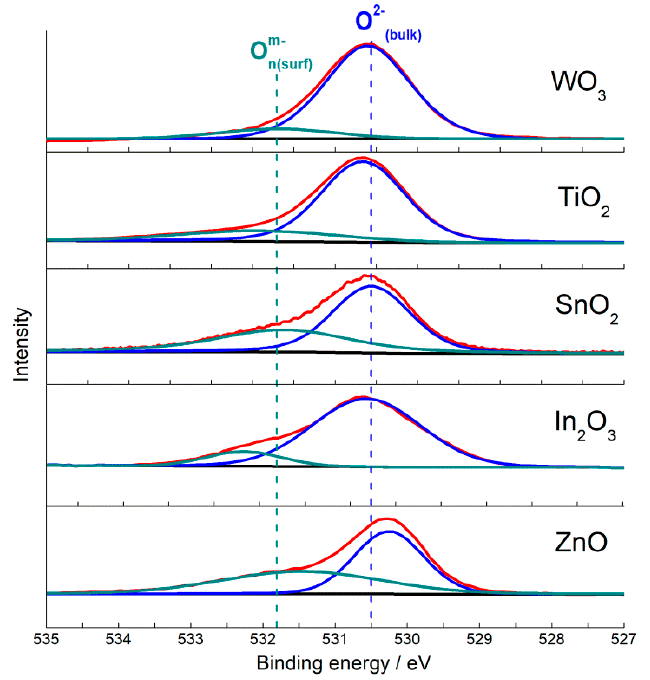
Figure 8. XP-spectra of O 1s state for nanocrystalline n -type MOS. Adapted with permissions from ref. [75] copyright 2018 Elsevier; ref. [78] copyright 2021 Elsevier; [79] copyright 2014 American Chemical Society; ref. [87] copyright 2010 Elsevier.